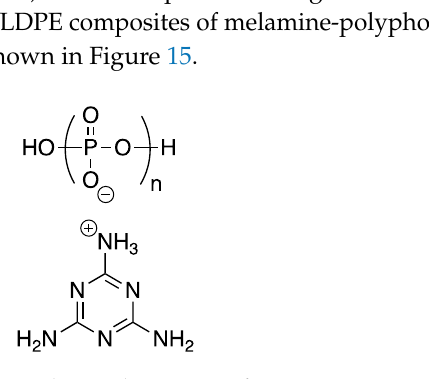
Figure 15. Chemical structure of 29 .